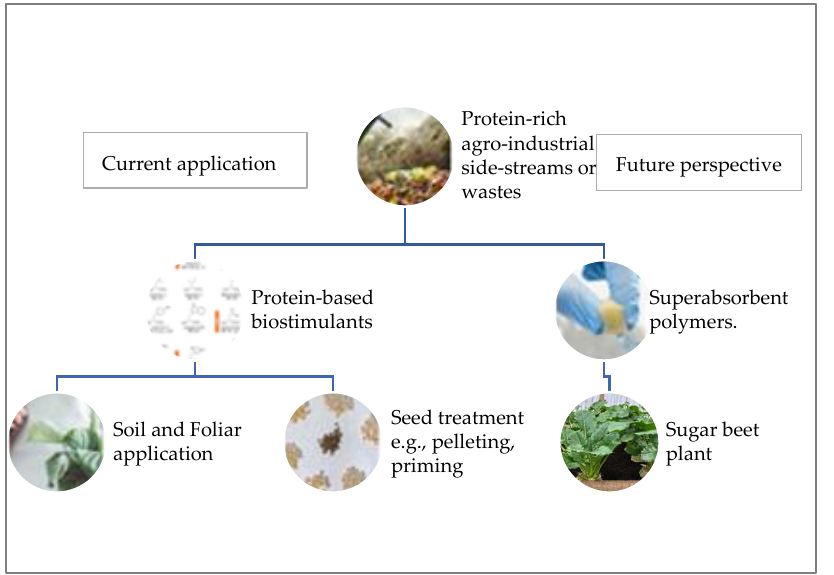
Figure 3. Chart illustrating current and possible future directions for the use of protein-based biostimulants (PBBs) developed from agro-industrial side streams.